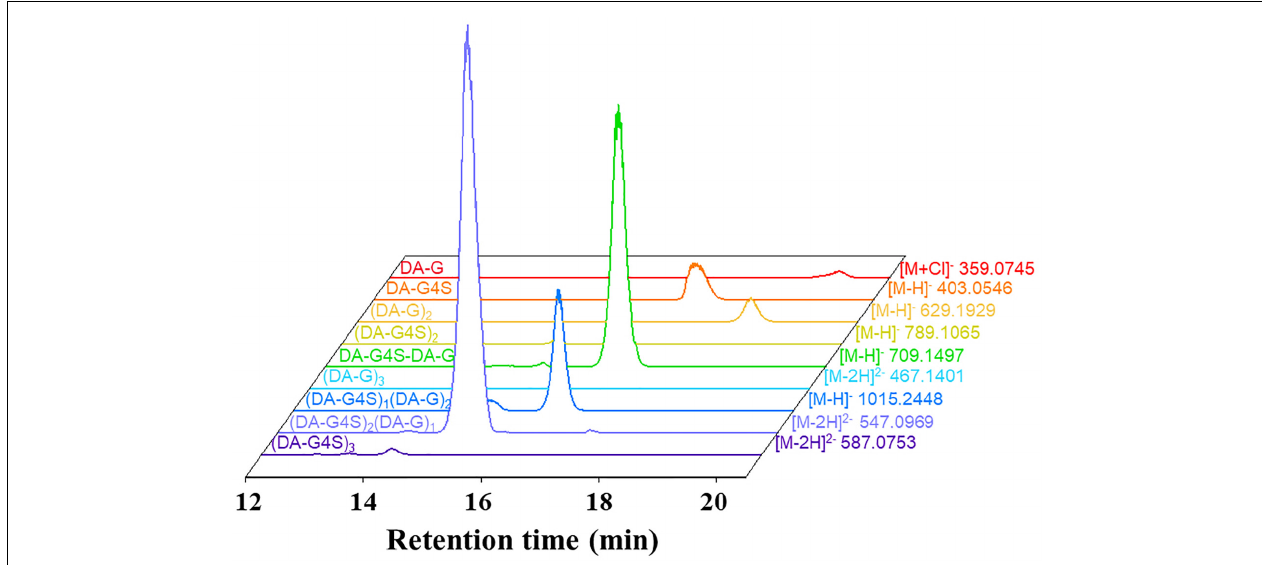
FIGURE 5 | Extracted ion chromatograms of oligosaccharides in the final product.